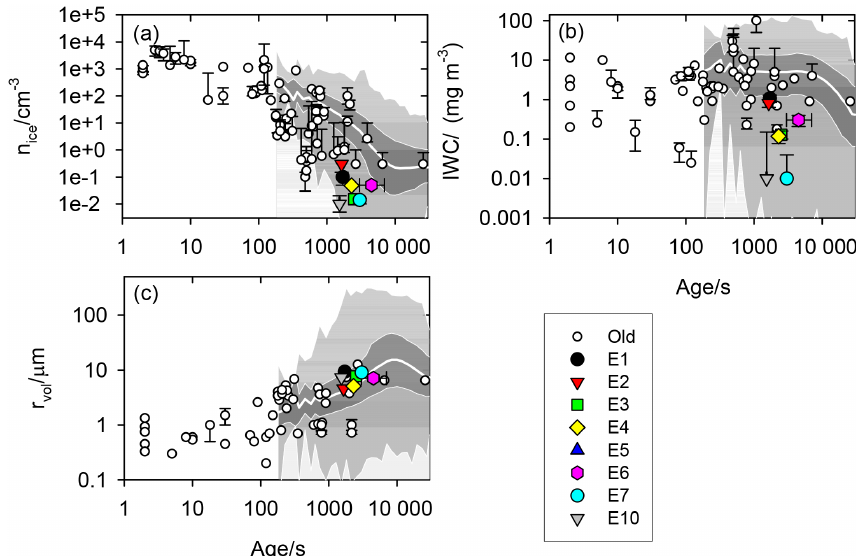
Figure 18. Contrail properties as function of contrail age. The gray ranges denote model results from the Contrail Cirrus Prediction (CoCiP) model coupled to the climate atmosphere and aerosol model CAM3–IMPACT (Schumann et al., 2015) with minimum and maximum values and white lines representing 10, 50, and 90% percentiles versus age, and the black symbols with error bars are the results from previous in situ and remote sensing measurements (Schumann and Heymsfield, 2017). The colored symbols are the data from Table 3 for events E1 to E10, 30 November 2005.